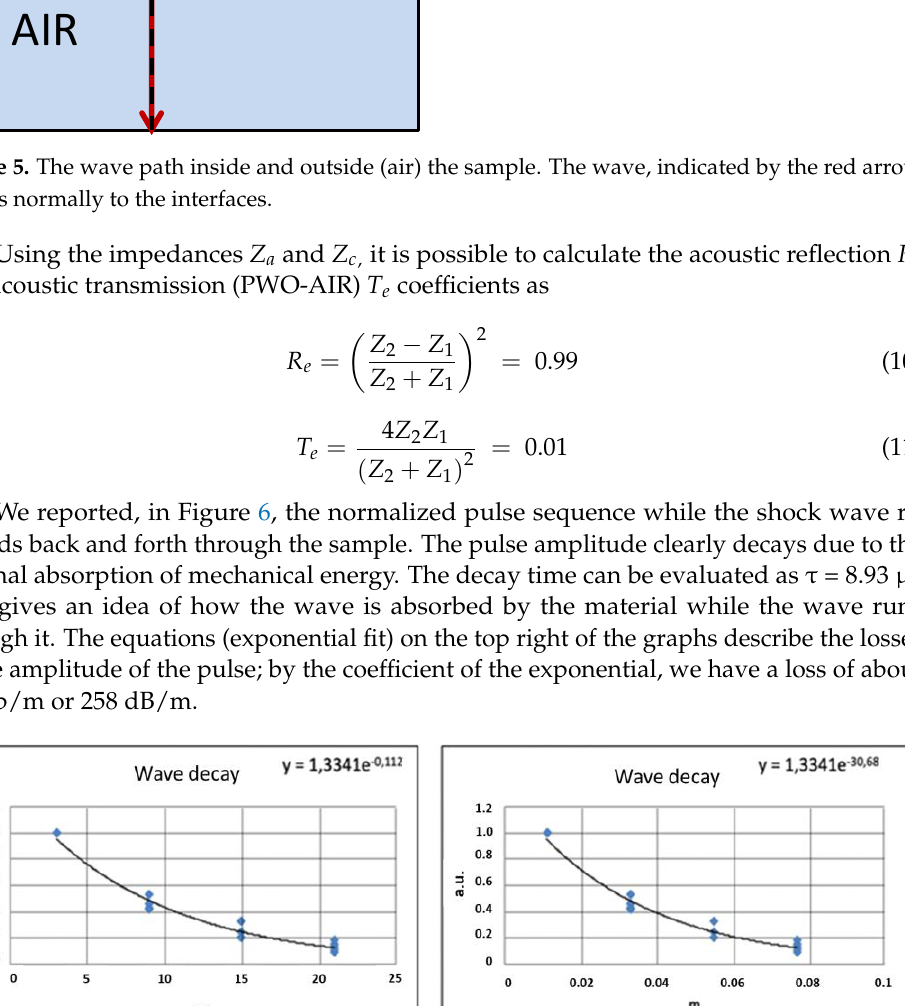
Figure 6. In the graph (on the left), the normalized wave pulse amplitude A (a.u. normalized) is displayed. On the right, is shown the length crossed by the wave, considering the evaluated sound speed inside the crystal. On the left, the pulse decay is reported as a function of time, on the right the displacement in a function of time.